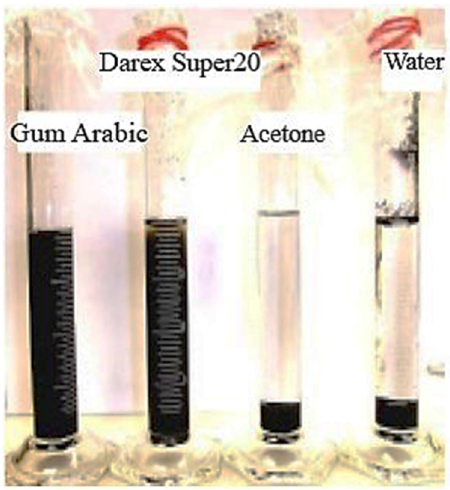
Figure 3: Ultrasound combined with Darex Super20 dispersion e ff ect [ 41 ] .